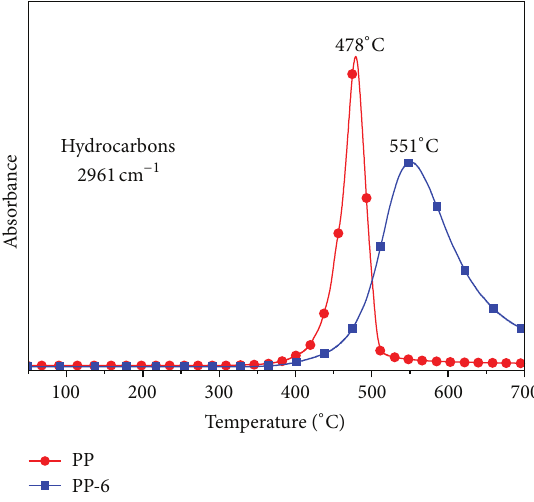
Figure 9: FTIR absorbance versus temperature curves of hydrocarbons evolved from PP and PP-6.